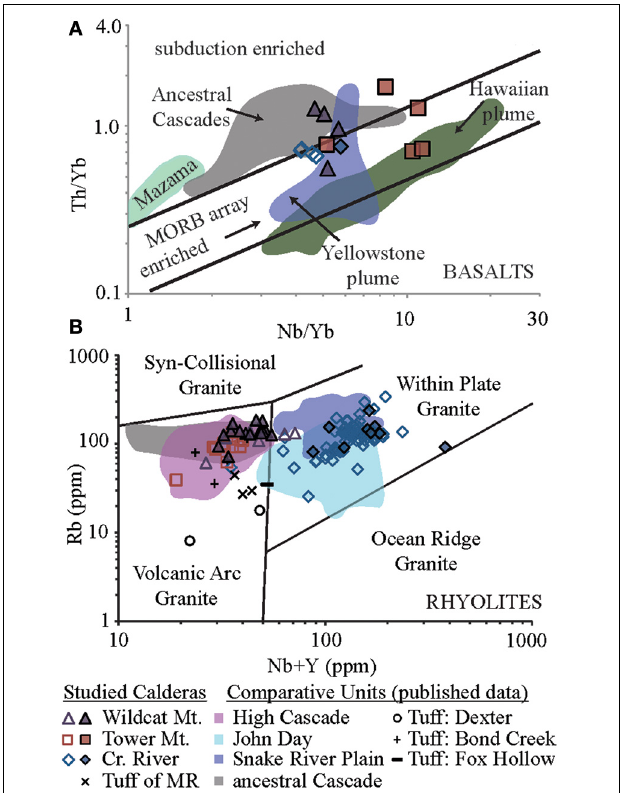
FIGURE 2 | Trace element data for rocks from the studied calderas and other nearby Cenozoic volcanic rocks (see the Supplementary Material). (A) Discrimination diagram showing trace element ratios for pre- and post- caldera basalts associated with the three eastern Oregon calderas; data field boundaries from Pearce and Peate (1995). All of the basalts have elevated Nb/Yb and Th/Yb relative to N-MORB. For caldera data, closed symbols are from this study and open symbols represent compiled published data from multiple sources (see Supplementary Material for References). (B) Trace element discrimination diagram of Pearce et al. (1984) showing the relative abundances of Rb vs. Nb + Y in rocks from the four studied calderas vs. those of other nearby Cenozoic volcanic rocks, including specific tuffs of the ancestral Cascades (Dexter, Bond Creek, and Fox Hollow). The distinct overlap in the compositions of the Snake River Plain rocks of the Yellowstone hotspot track and those of the Crooked River rhyolites suggests similar petrogenetic